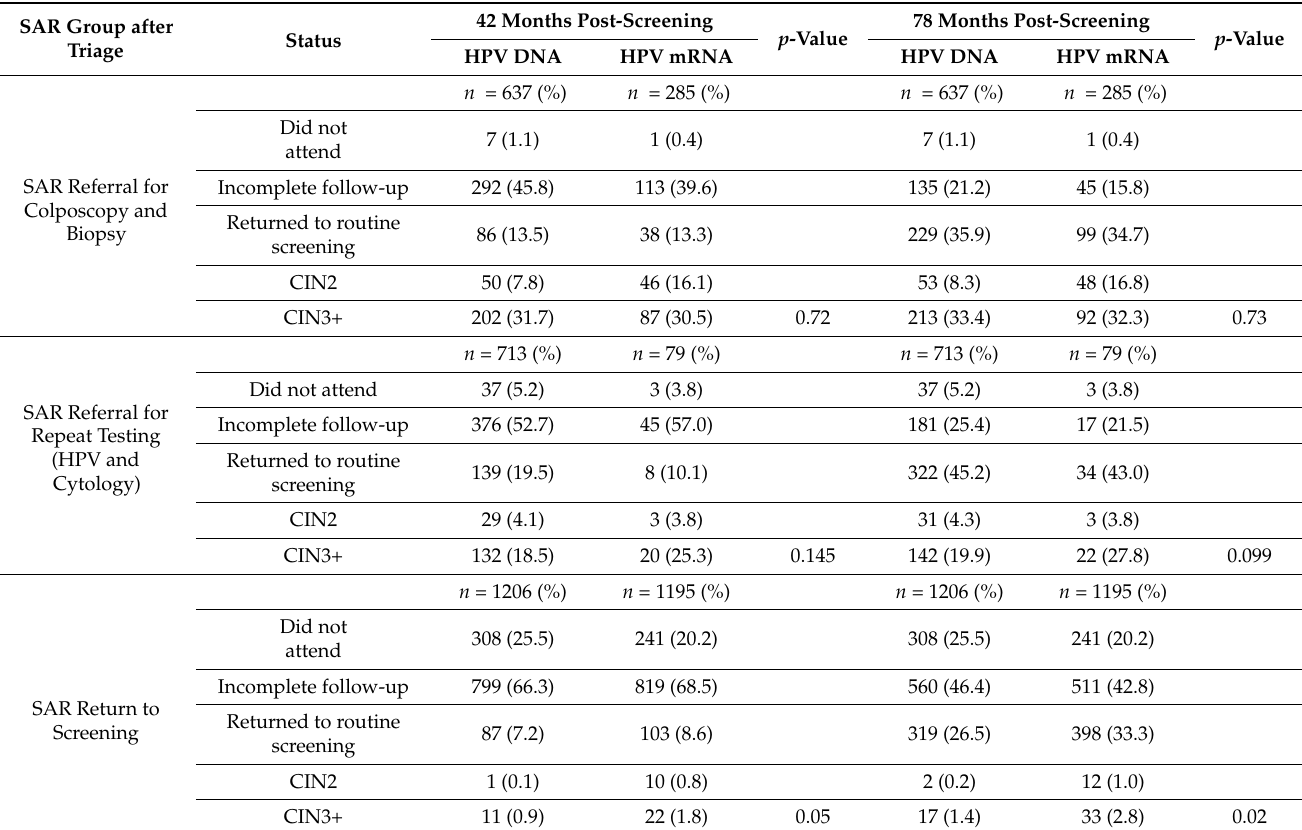
Table 3. Status and CIN3+ detection rates at 42 and 78 months post-screening by the screening algorithm-recommended (SAR) group after triage among HPV DNA-tested and HPV mRNA- tested